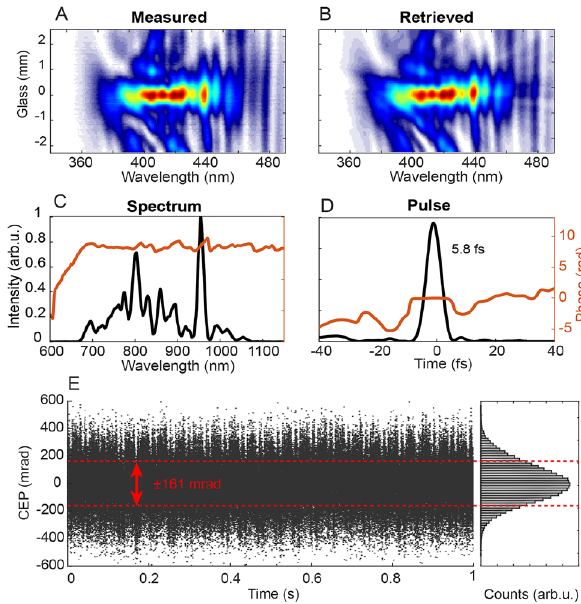
Figure 2: Laser output characterization. (A)Measuredand(B)retrievedd-scantraces;ad-scantraceisatwo- dimensional representation of the second harmonic signal (intensity in colors) as a function of wavelength and glass insertion; (C) retrieved spectrum(black) and spectral phase (red), (D) retrieved temporal pulse intensity profile (black) and phase (red), (E) single- shot carrier-to-envelope phase (CEP) measurement, showing the measured CEP as a function of time; the root mean square is indicated in red (see the histogram plot on the